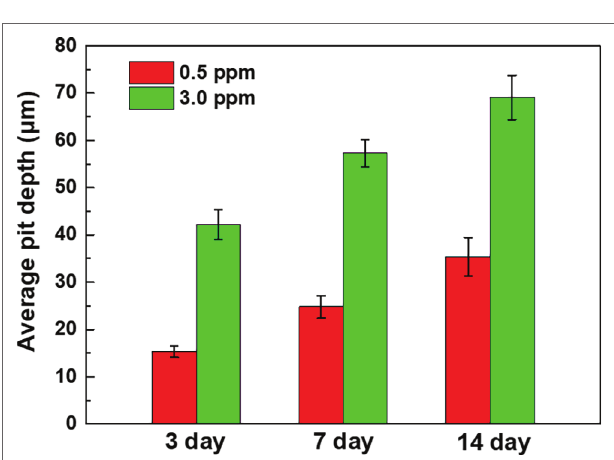
FIGURE 5 | Average pit depths of the samples after 3, 7, and 14 days of immersion in 0.5 ppm and 3.0 ppm inoculated